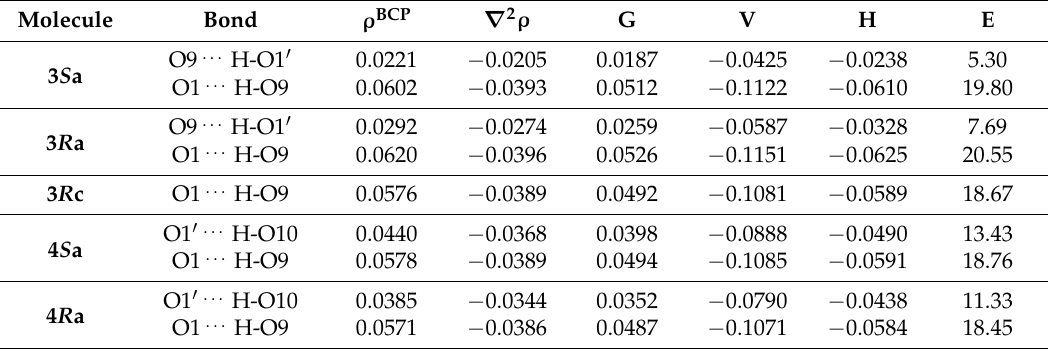
Table 12. Atoms-in-molecules parameters for 3 and 4 . Electron density at the critical point ρ BCP (a.u), its Laplacian ∇ 2 ρ (a.u.), electron kinetic energy density G (a.u.), potential energy density V (a.u.), total